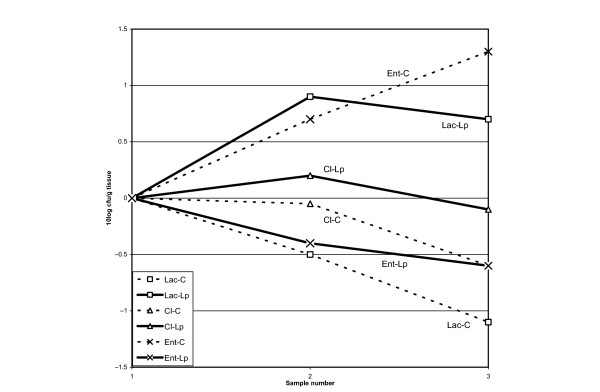
Changes of bacterial counts from rectal biopsies (means): comparisons with the initial sample. The Enterobacteriaceae (Ent) species show a 10-fold increase in mean values in the control (-C) group while Lactobacillus (Lac) decrease 10-fold. In contrast, in the treatment group (-Lp) Lactobacillus (Lac) increase and Enterobacteriaceae decrease. Sulphite reducing clostridia (Cl) decrease in the control group. cfu, colony-forming units.